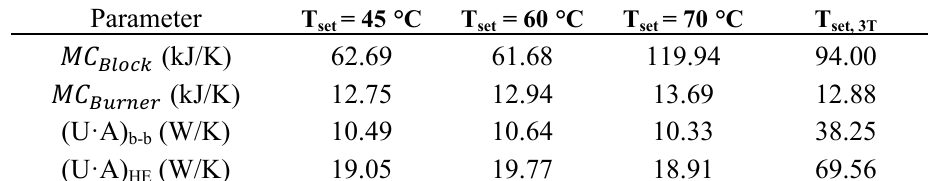
, MC , (U·A) , and (U·A) after model calibration for the Block burner b-b set, 3T